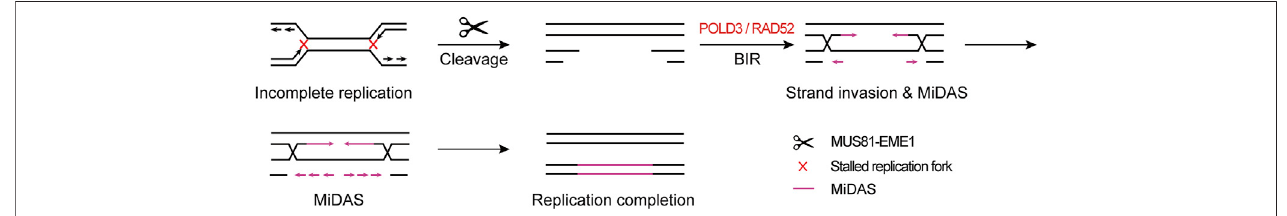
FIGURE 3 | Model of “ double fork failure ” and “ break-induced replication ” . Under replication stress, both of the replication forks at CFSs stall, namely “ double fork failure ” , and CFSs remain under-replicated before mitosis. In prometaphase, both of the stalled forks are cleaved by MUS81-EME1 complex, giving rise to the DSB formation. Thereafter, two head-on forks restart replication through BIR, which is dependent on POLD3 and